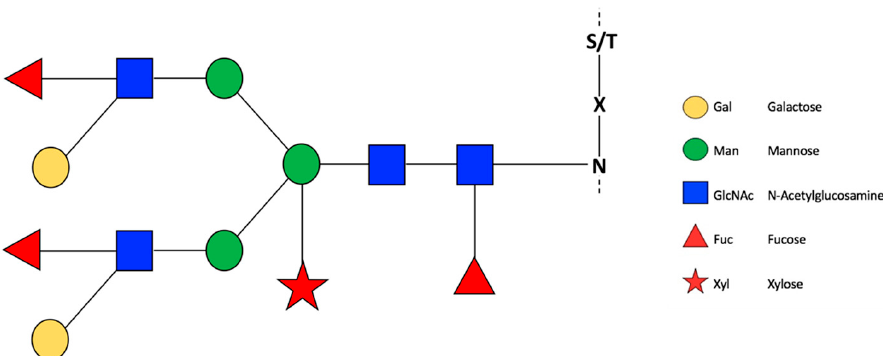
Figure 1. General representation of N -glycosylation in plants. Glycans are represented according to Consortium for Functional Glycomics (CFG). Recovered with modifications of Wang et al. [32].